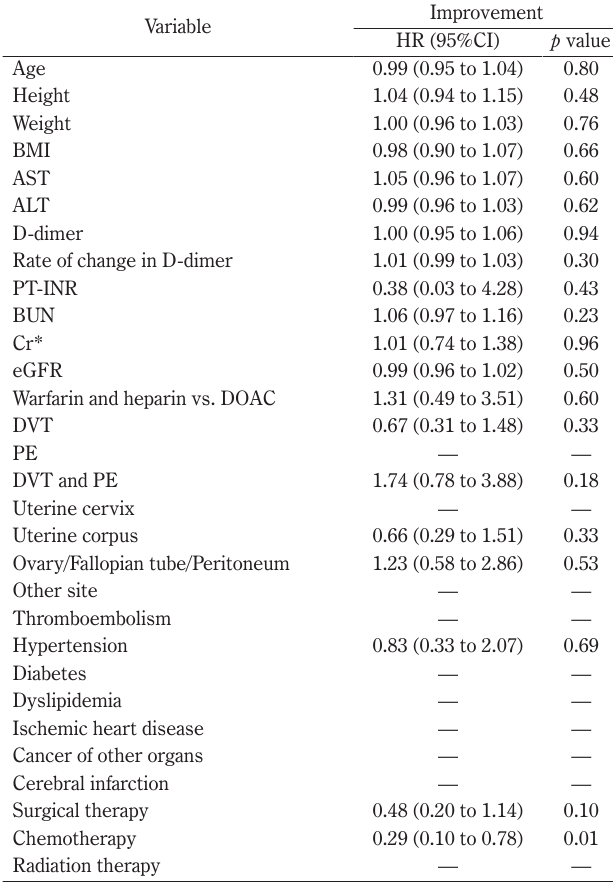
Table 2 Predictors by Cox univariate analysis